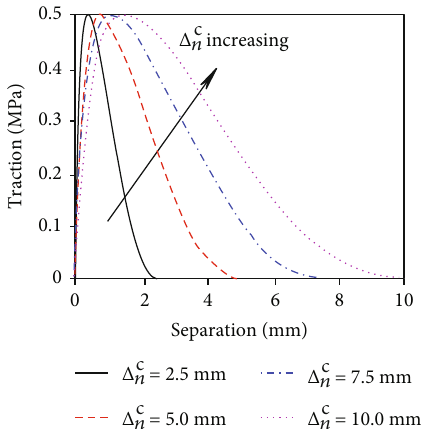
Figure 4: Response under di ff erent critical displacement Δ c σ = 0 : 5MPa , m = 0 : 1672 , α = 3 : 10 [40]. Figure max